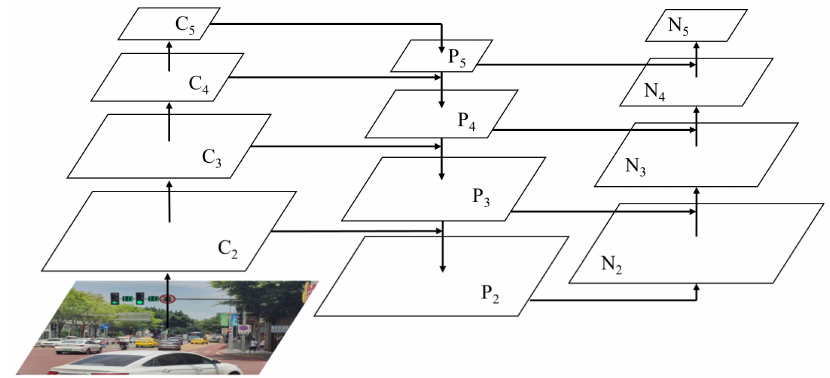
Figure 3. Network structure of PANet.